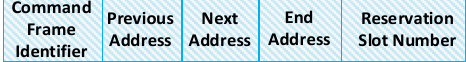
Figure 4. Format of the reservation request message.